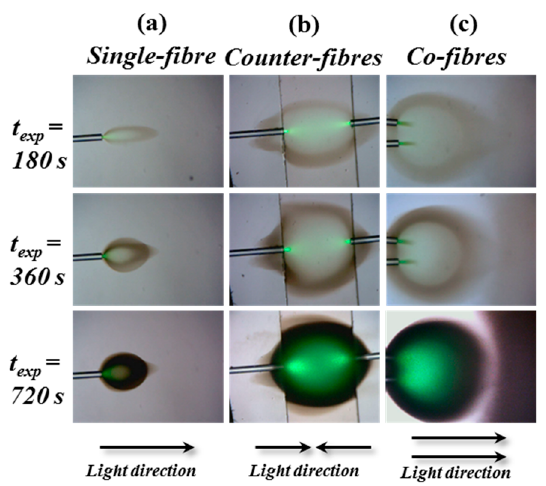
Figure 3. Microscope images of the spherical shapes created at the end of an optical fiber ( λ = 532 nm and P 0 = 0.1 mW) inside the liquid photosensitive solution. The three exposure geometries involve illumination using ( a ) single-fiber, ( b ) counter-fibers, and ( c ) co-fibers. In each case, the results for three exposure times (180 s, 360 s, and 720 s) are presented.